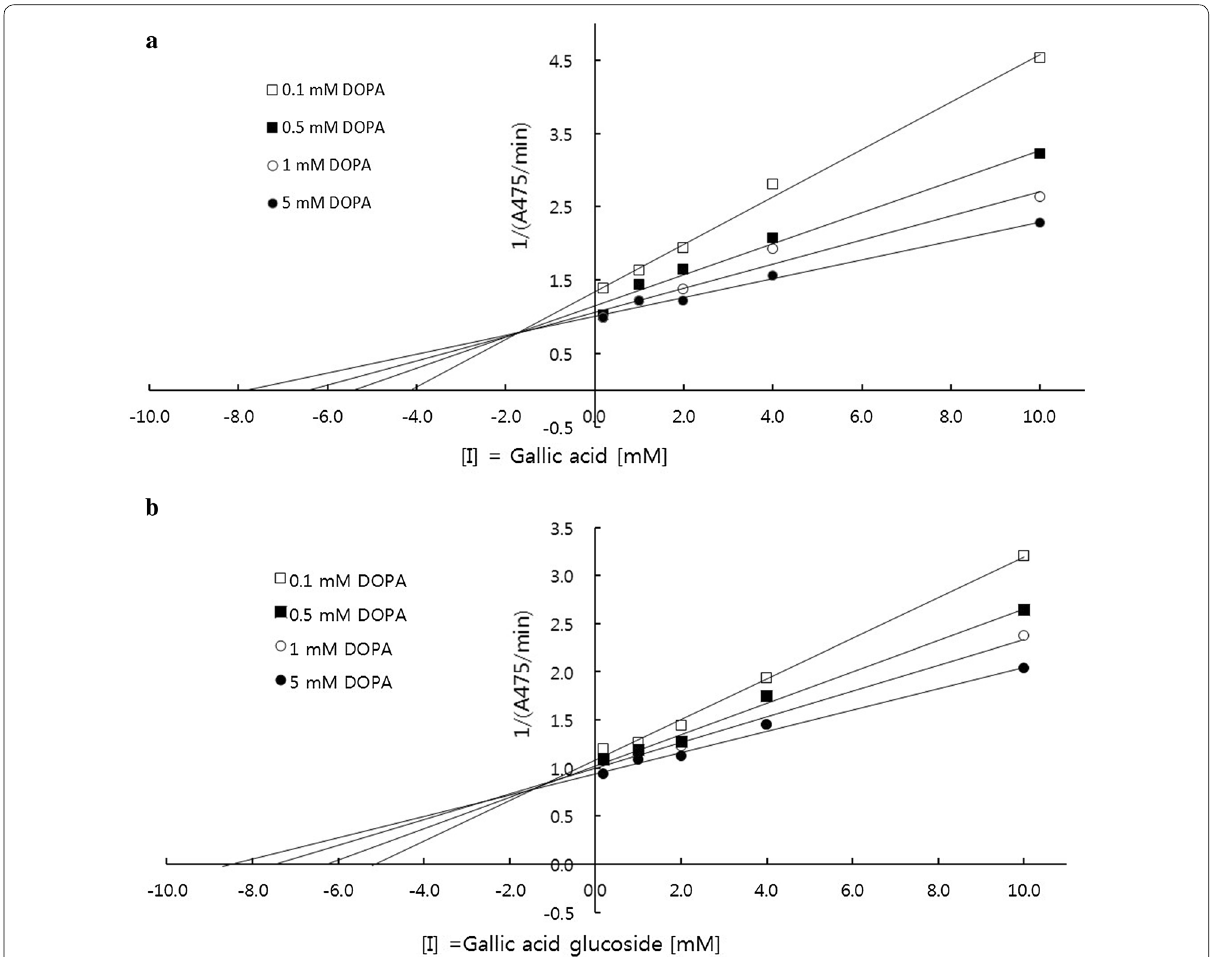
Fig. 5 Dixon plots showing the reciprocal of the velocity (1/υ) of the mushroom tyrosinase reaction against the inhibitor 0–10 mM gallic acid ( a ) or gallic acid glucoside ( b ). Various substrate concentrations of l ‑DOPA (0.1, 0.5, 1.0, 5.0 mM) were applied to obtain the Dixon plots. A475 represents an increase in the absorbance at 475